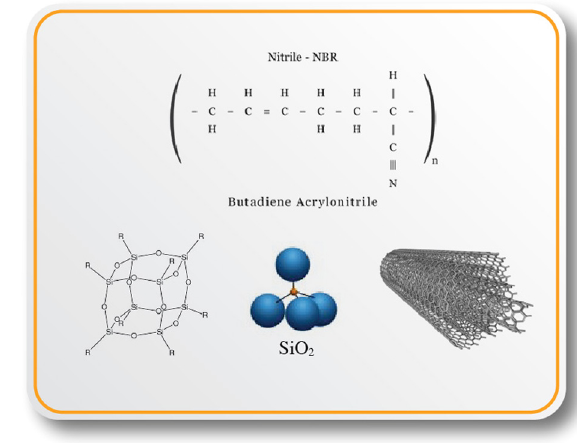
Figure 3: EPDM chemical formula and Kevlar fi bers used as an example of reinforcement.